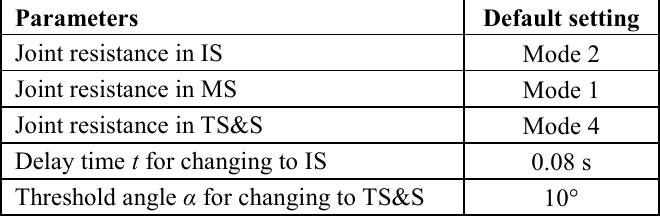
Table 1 Control rule tuning parameters and default settings